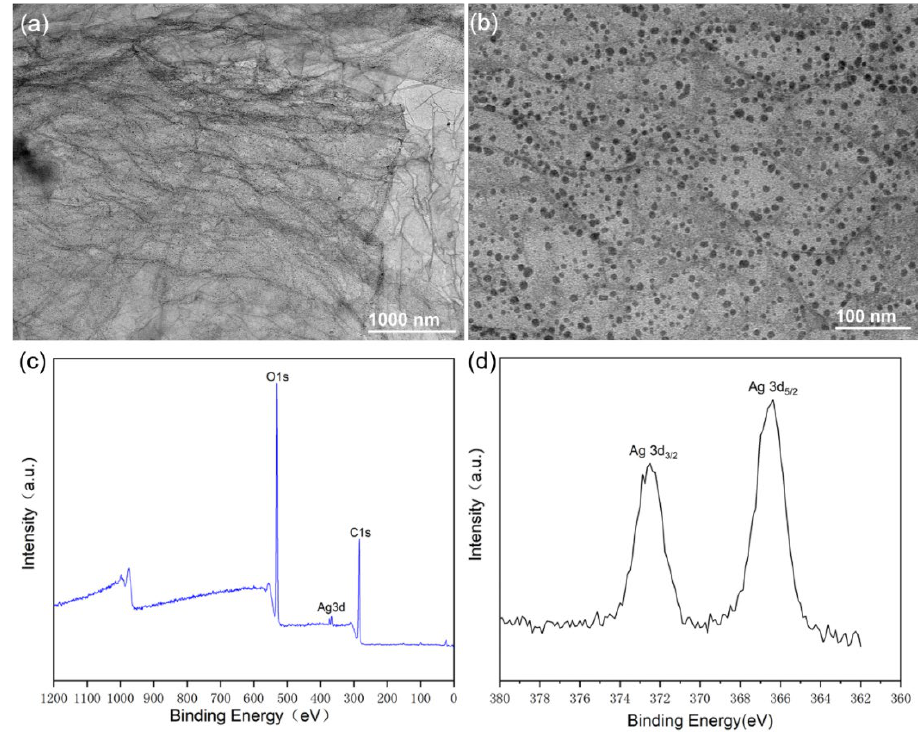
Figure 4. ( a , b ) TEM images of GO/PNF/AgNP suspensions. ( c , d ) XPS spectra of GO/PNF/AgNP hybrid membranes.